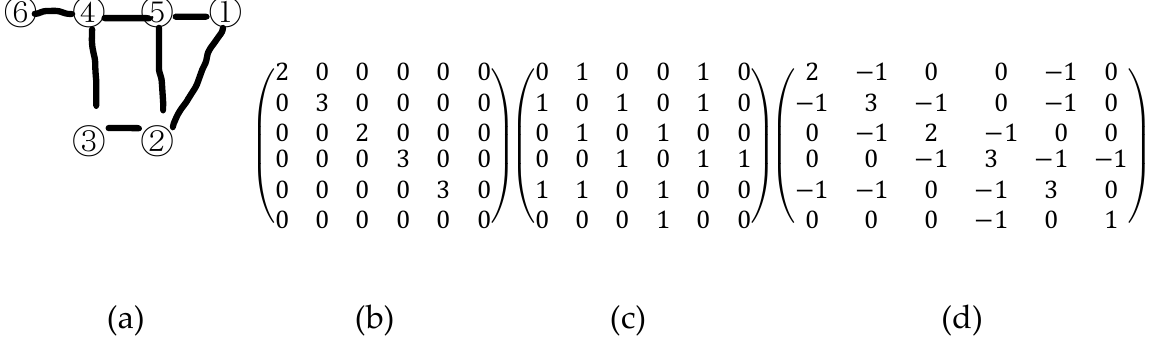
Figure 1. Representations of labeled graph, order matrix, adjacency matrix, and Laplacian matrix. (a) Labeled graph, (b) Order matrix, (c) Adjacency matrix, (d) Laplacian matrix